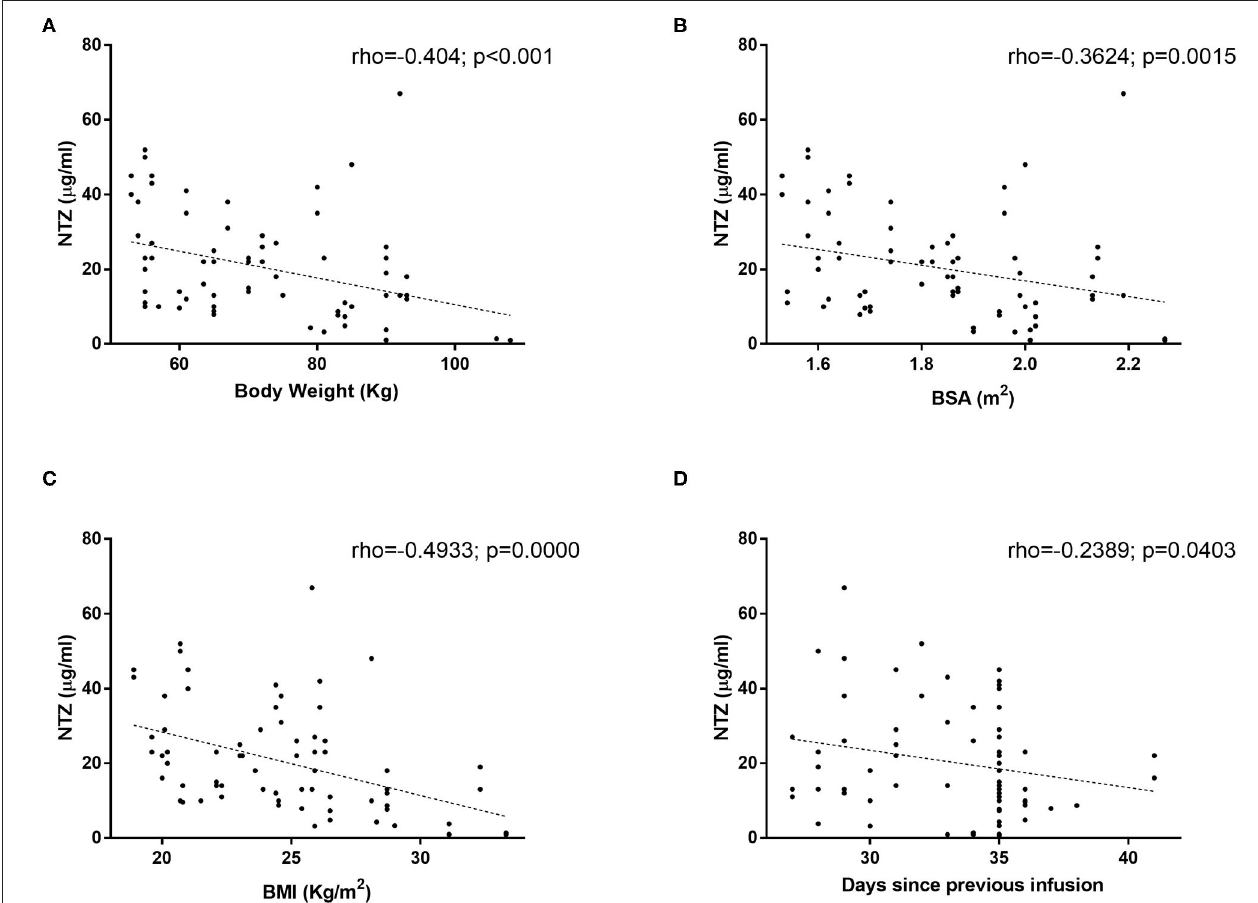
FIGURE 1 | Natalizumab serum concentration correlation to (A) body weight, (B) Body Surface Area (BSA), (C) Body Mass Index (BMI), and (D) scheme doses. Natalizumab concentration was measured with ELISA as described by Rispens et al. in 74 samples from 32 patients. Spearman’s correlation (rho) was used for association analysis of quantitative variables.